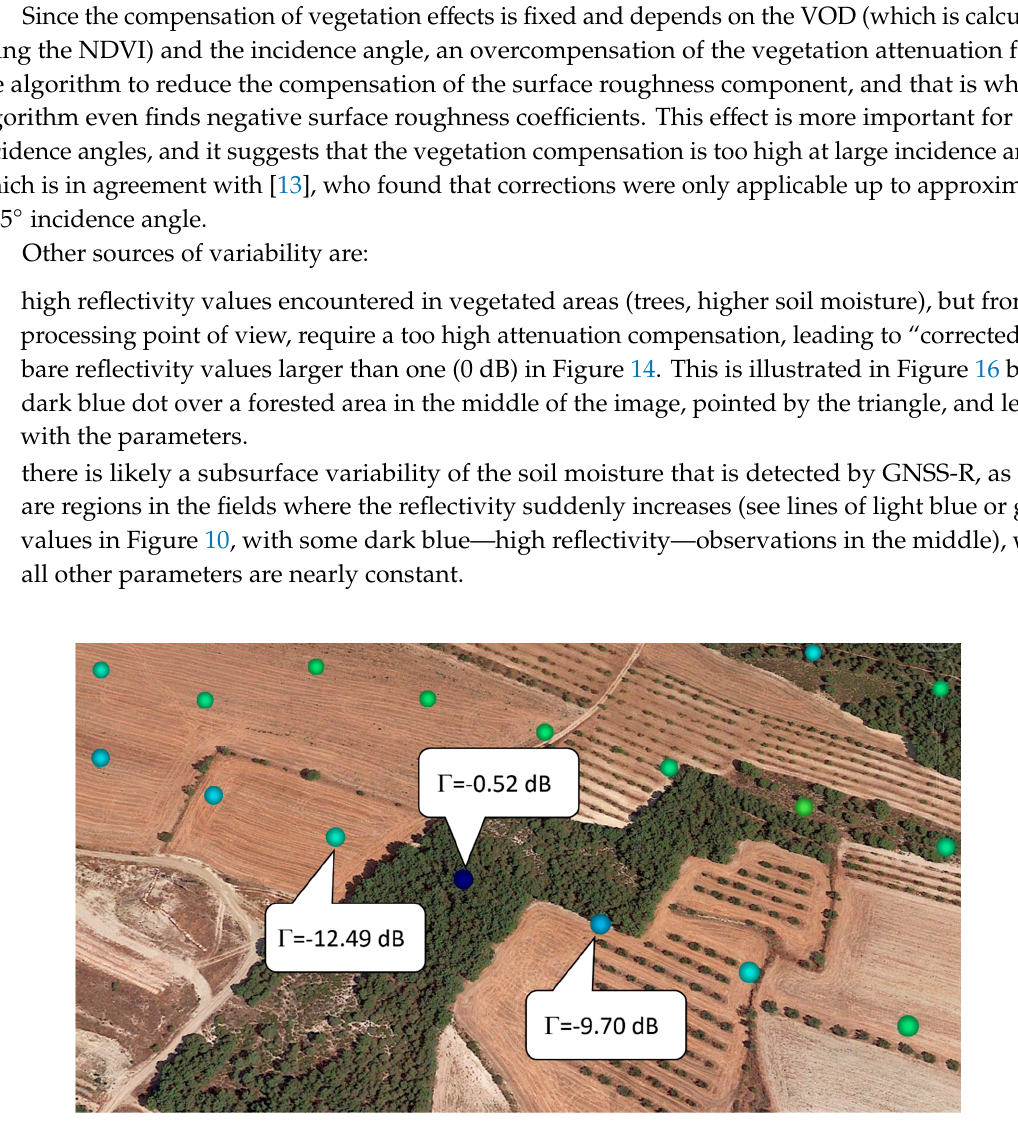
Figure 16. Sample high GNSS-R reflectivity (calibrated for instrumental effects) over the forested area that is overcompensated for vegetation attenuation effects, or areas in which there is likely a variation in the subsurface soil moisture.